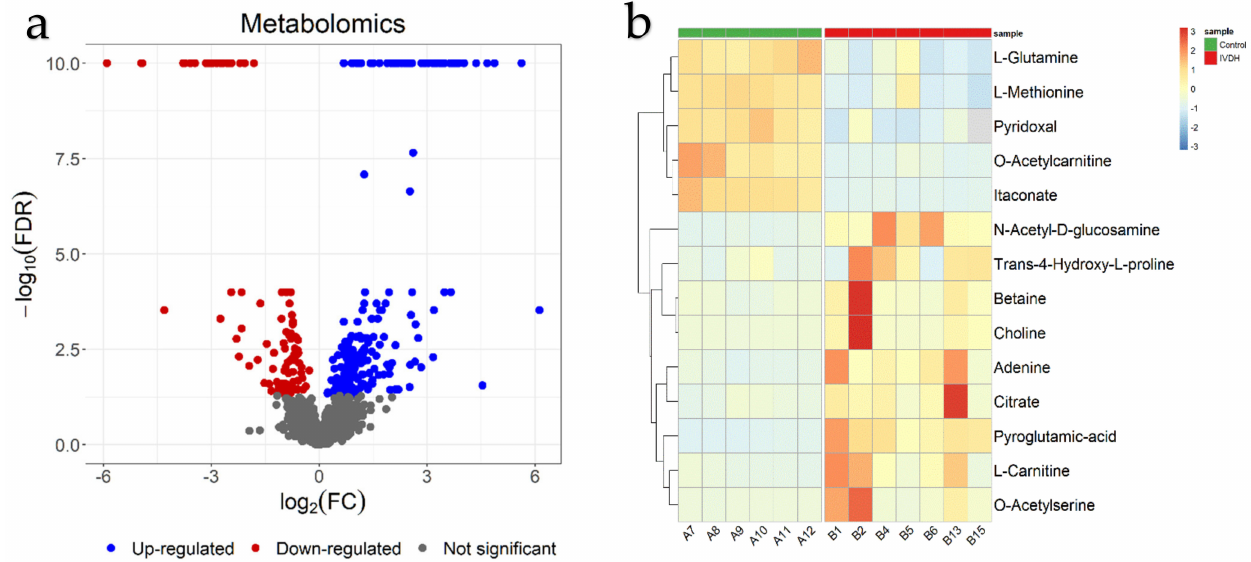
Figure 4. Statistical analysis of proteomics results: ( a ) Volcano plot of evaluated groups after false discovery rate (FDR) correction. Proteins overexpressed in intervertebral disc herniation (IVDH) group are in red, lower-expressed are in blue.; ( b ) Heatmap revealing the differentially expressed genes in the control and IVDH groups. Each row represents fold change (FC) expressed as the log2FC of a single gene across all samples. Table 3. List of identified (using authentic standards) significantly changed metabolites in cerebrospinal fluid of interver- tebral disc herniation (IVDH) group compared to healthy dogs obtained using the Polyomics integrated Metabolomics Pipeline